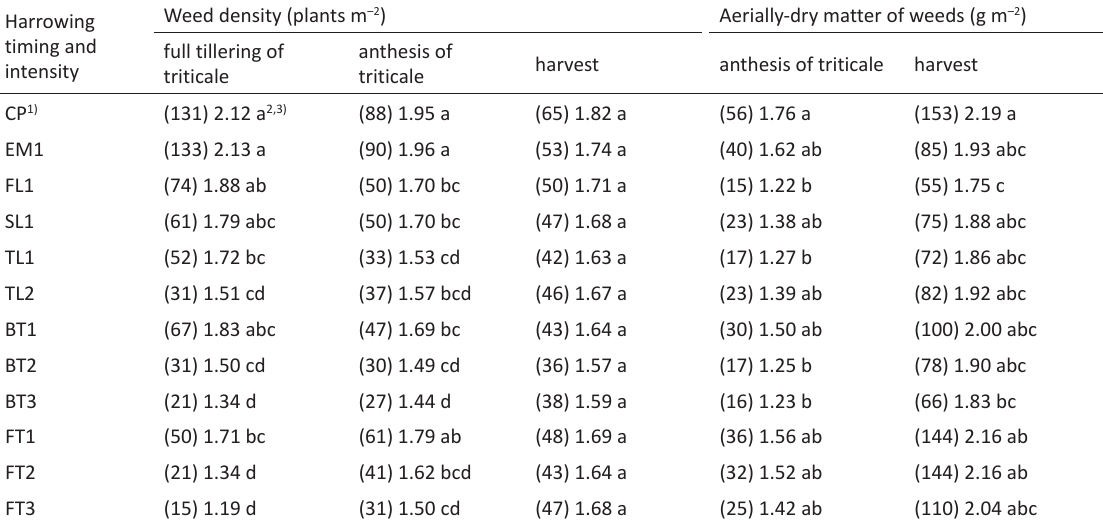
Table 4. The effect of weed harrowing on the weed density and the weed biomass during growth of triticale-lupin mixture. Means averaged over 2015–2017. Harrowing timing and